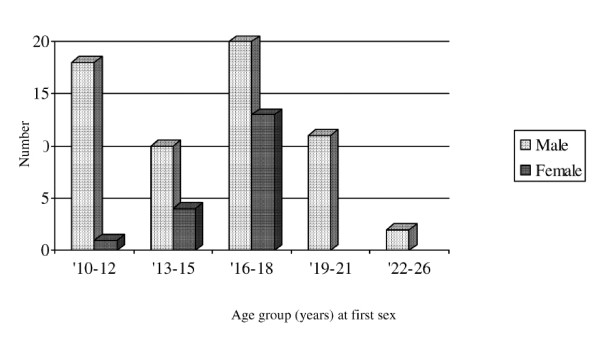
Age at first sex of secondary school students by gender.